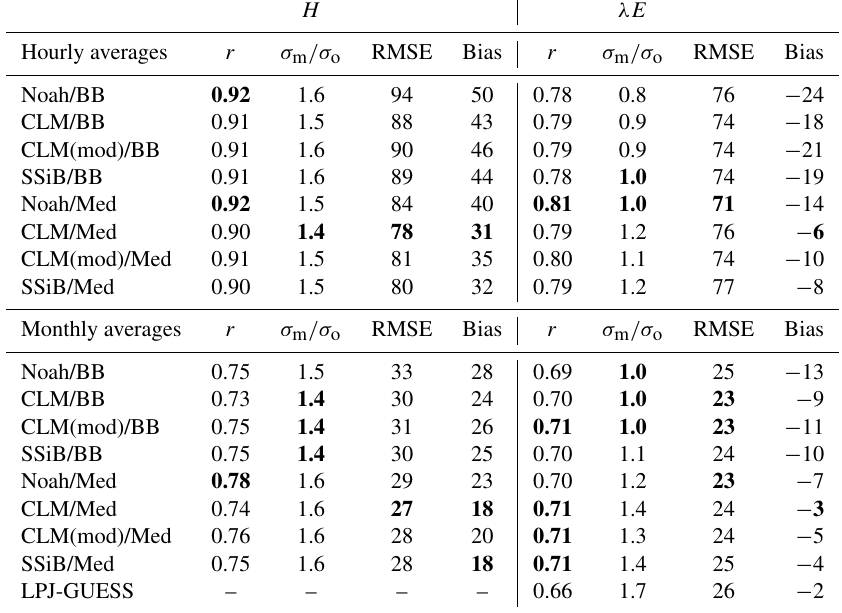
Table 8. Cross-site averaged model performance statistics for simulated hourly and monthly sensible and latent heat fluxes. RMSE and bias are given in Wm − 2 . Bold fonts indicate the best-performing simulations in each